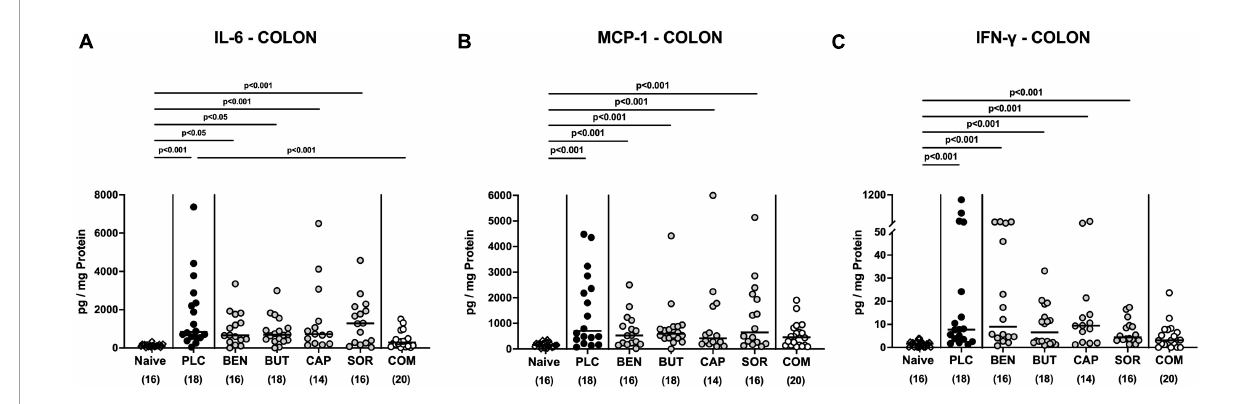
FIGURE6 Colonic pro-inflammatory mediator responses upon single and combined organic acid treatment. Infected mice received benzoic acid (BEN), butyric acid (BUT), caprylic acid (CAP), sorbic acid (SOR), a combination of all acids (COM) or placebo (PLC). On day 6 post-infection, pro-inflammatory mediators including (A) IL-6, (B) MCP-1, and (C) IFN- γ were measured in supernatants of ex vivo biopsies derived from the colon. Naive mice served as negative controls. Medians (black bars), significance levels ( p values) calculated by the ANOVA test with Tukey’s post-correction or by the Kruskal–Wallis test and Dunn’s post-correction, and the total mice numbers (in parentheses) are given. Data were pooled from three independent experiments.